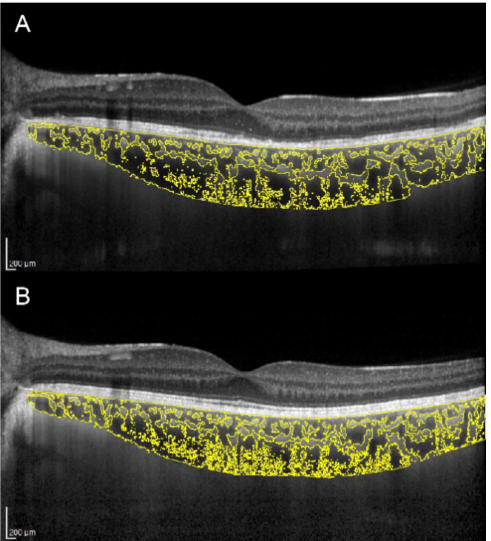
Figure 2. Choroidal vascularity index evaluation in a patient with multiple evanescent white dot syndrome. ( A ) In the acute stage, OCT shows ellipsoid zone disruption and a CVI of 69.3%. ( B ) In the healed stage, OCT shows normalization of the ellipsoid zone and a CVI decreased to